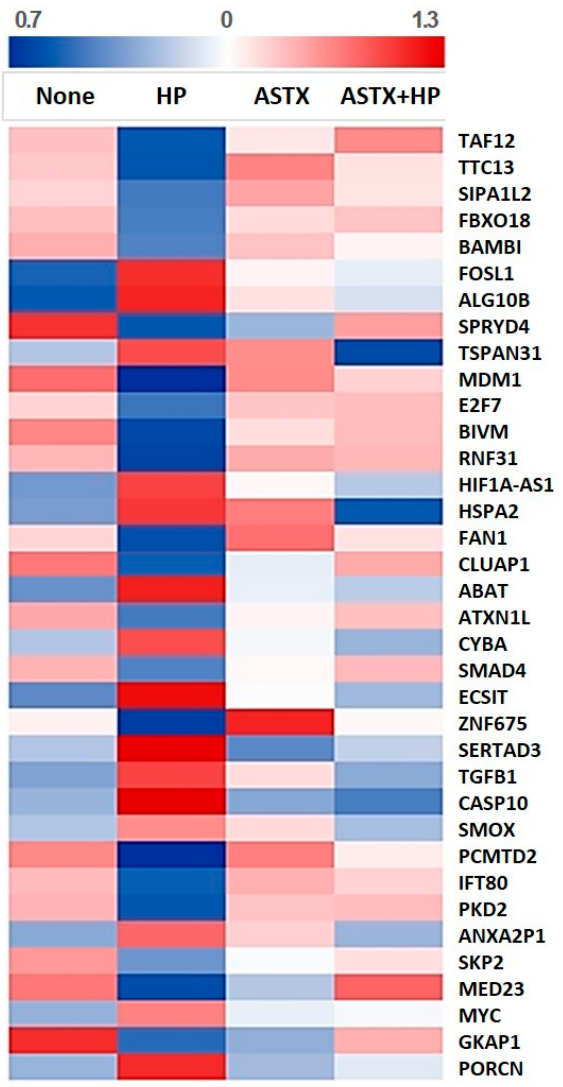
Figure 3. Heatmap representation of the expression levels of candidate DEGs. The color gradient visualizes the fold change values of each gene expression, where blue represents downregulated expression and red represents upregulated expression.